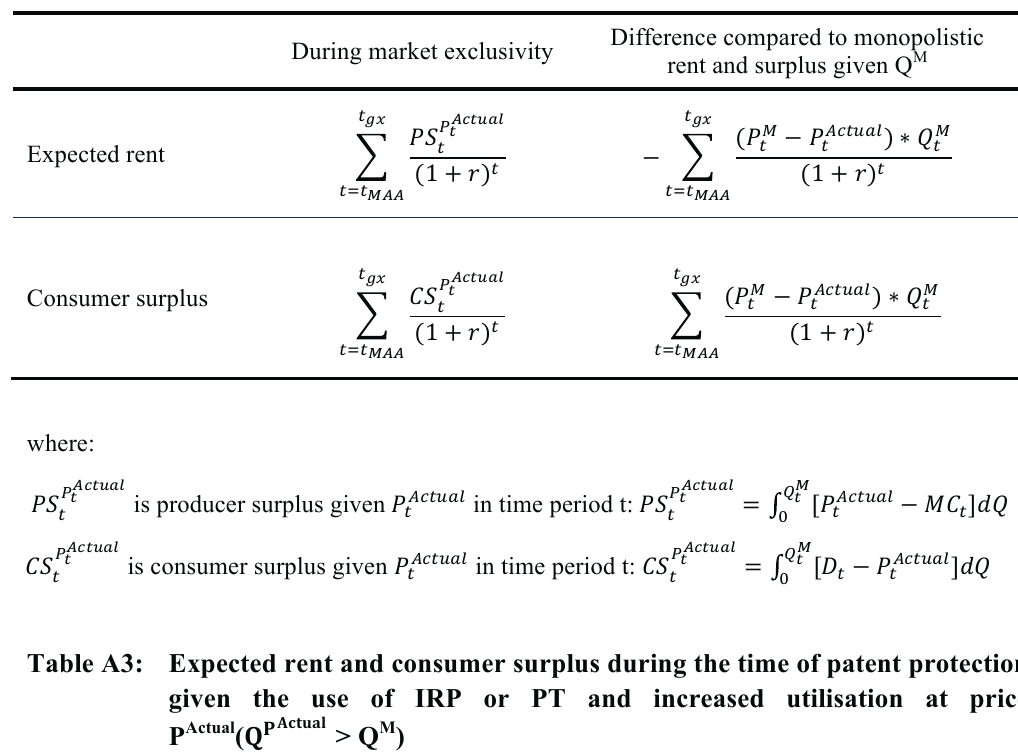
Rent & surplus during Rent and surplus difference compared to patent protection monopolistic rent and surplus given Q M